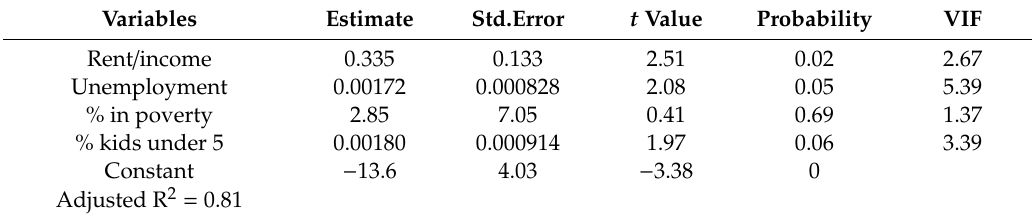
Table 3. Regression of relationship between socioeconomics of the neighborhood and cruelty (Several demographic variables were removed from the equation due to high VIFs including: median household income, % with a bachelor’s degree, and % with a high school degree.).